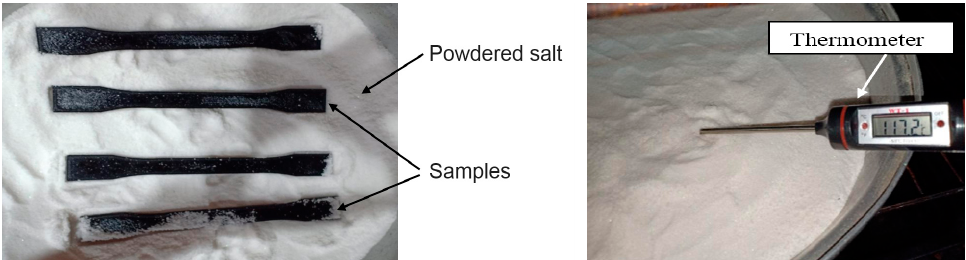
Figure A3. Annealing process.